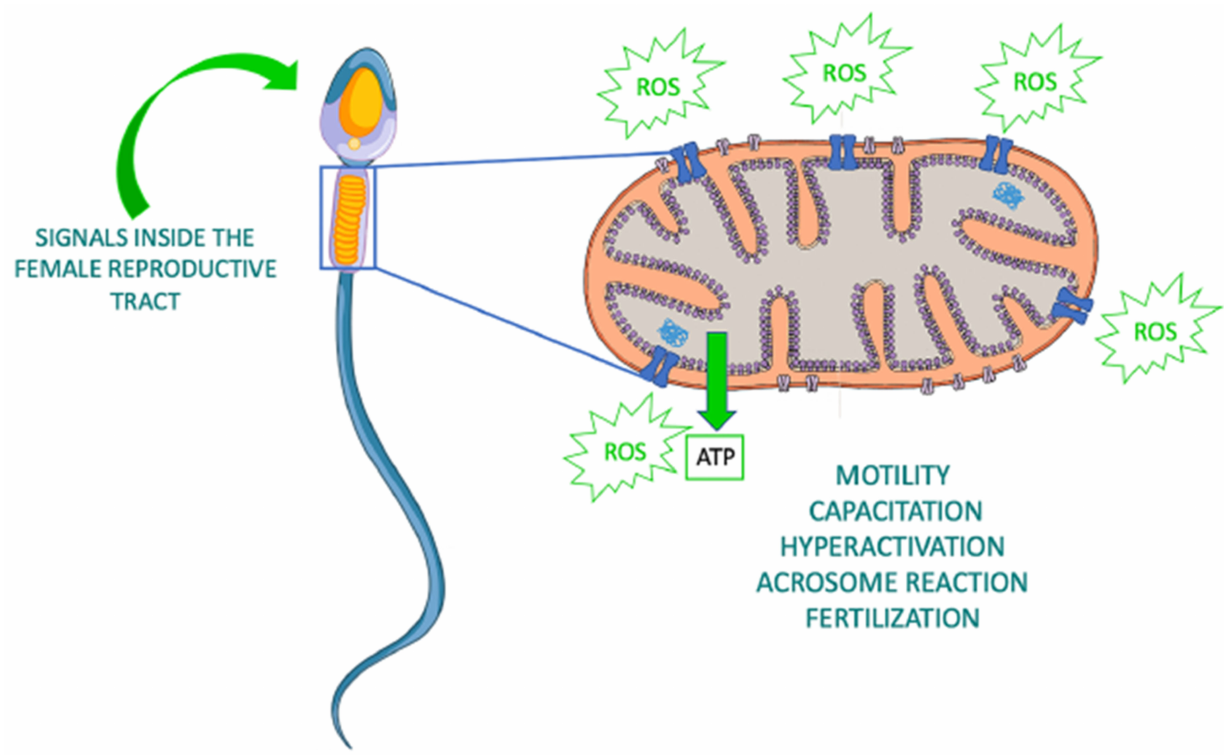
Figure 1. Roles of sperm mitochondria in health. Production of ATP and ROS by sperm mitochondria is involved in several sperm functions. Modified from https://www.vecteezy.com/vector-art/1434164-human-sperm-or-spermatozoa- cell-structure (accessed on 28 December